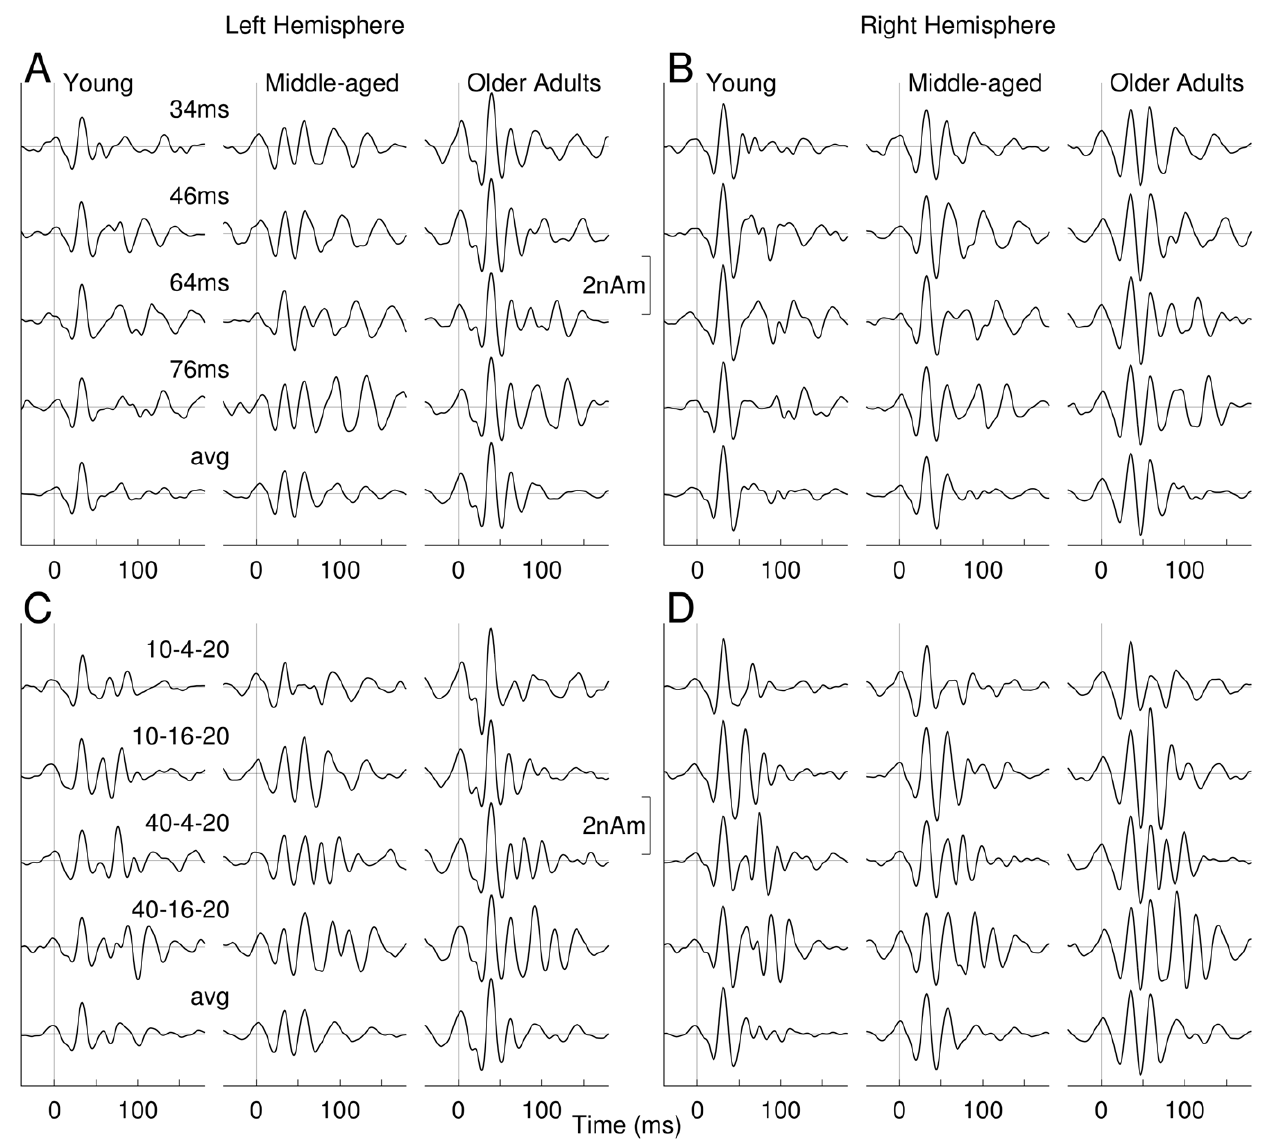
Figure 5. Waveforms of transient gamma band responses for the three age groups, eight stimulus types and left and right hemispheres. (Time zero refers to the stimulus onset.) A : Responses to no-gap stimuli as observed in the left hemisphere. The bottom trace shows the response waveform averaged across the four stimuli with different duration. B : Right hemispheric responses to no-gap stimuli. C–D : Responses to gap-stimuli